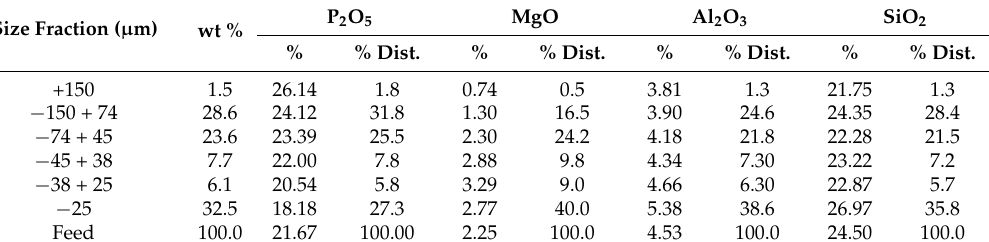
Table 4. Particle size and chemical analyses of the feed (Dist.: distribution).